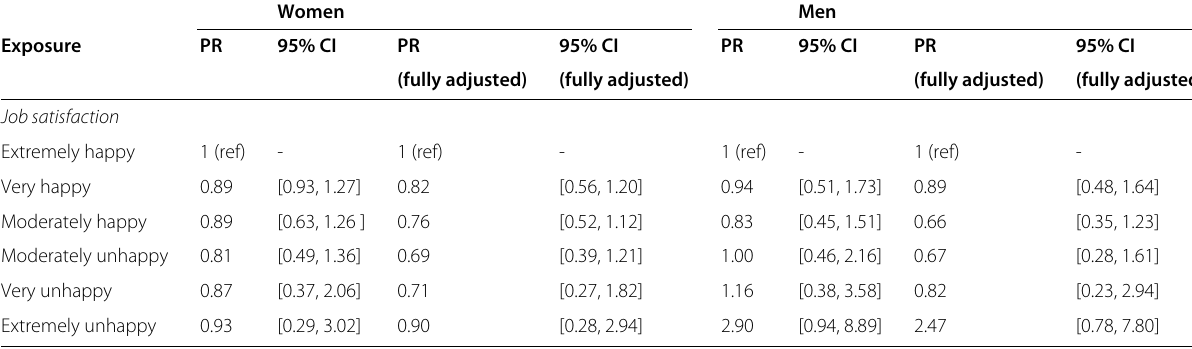
Table 6 Prevalence of migraineurs among different job-related categories (work satisfaction) Women